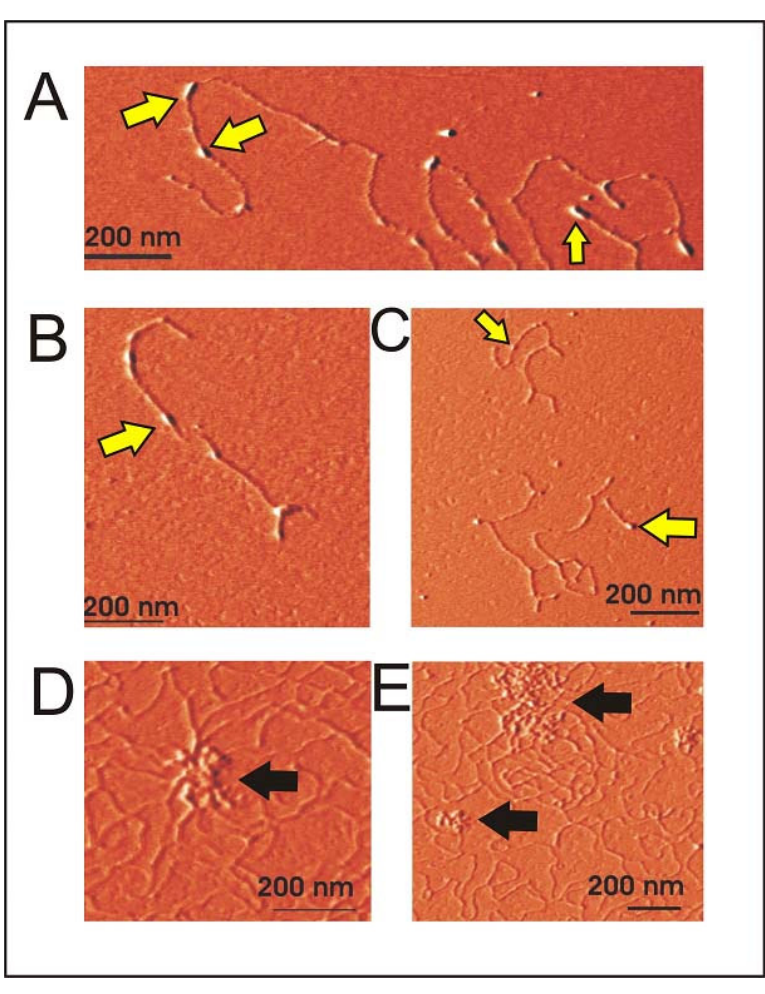
FIGURE 3. AFM 2D images of DNA obtained from the VBNC forms of M. gallisepticum S6 in air. (A–C) and (D,E) DNAs in concentration 0.15 and 0.45 ng/ µ L, respectively. The yellow arrows, the sites of the possible binding DNA with Mg conglomerates; black arrows, the sites of DNA entwinement.